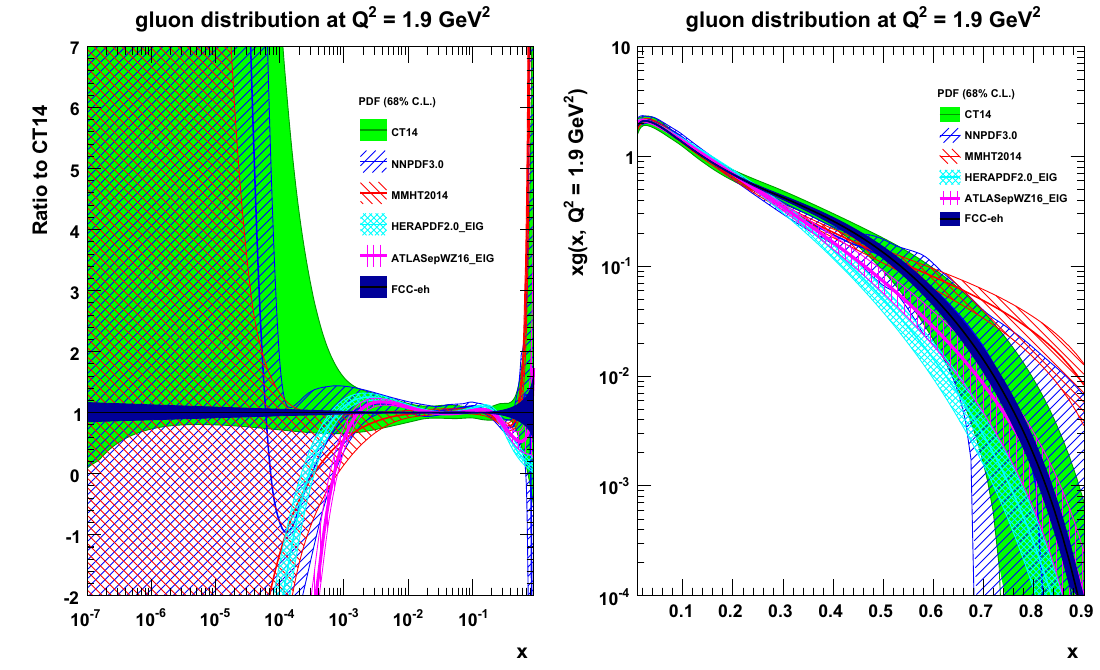
Fig. 5.12 Gluon distribution at Q 2 = 1 . 9 GeV 2 as a function of Bjorken x . The FCC-eh PDF uncertainties, adjusted to the central value of CT14, correspond to the dark blue